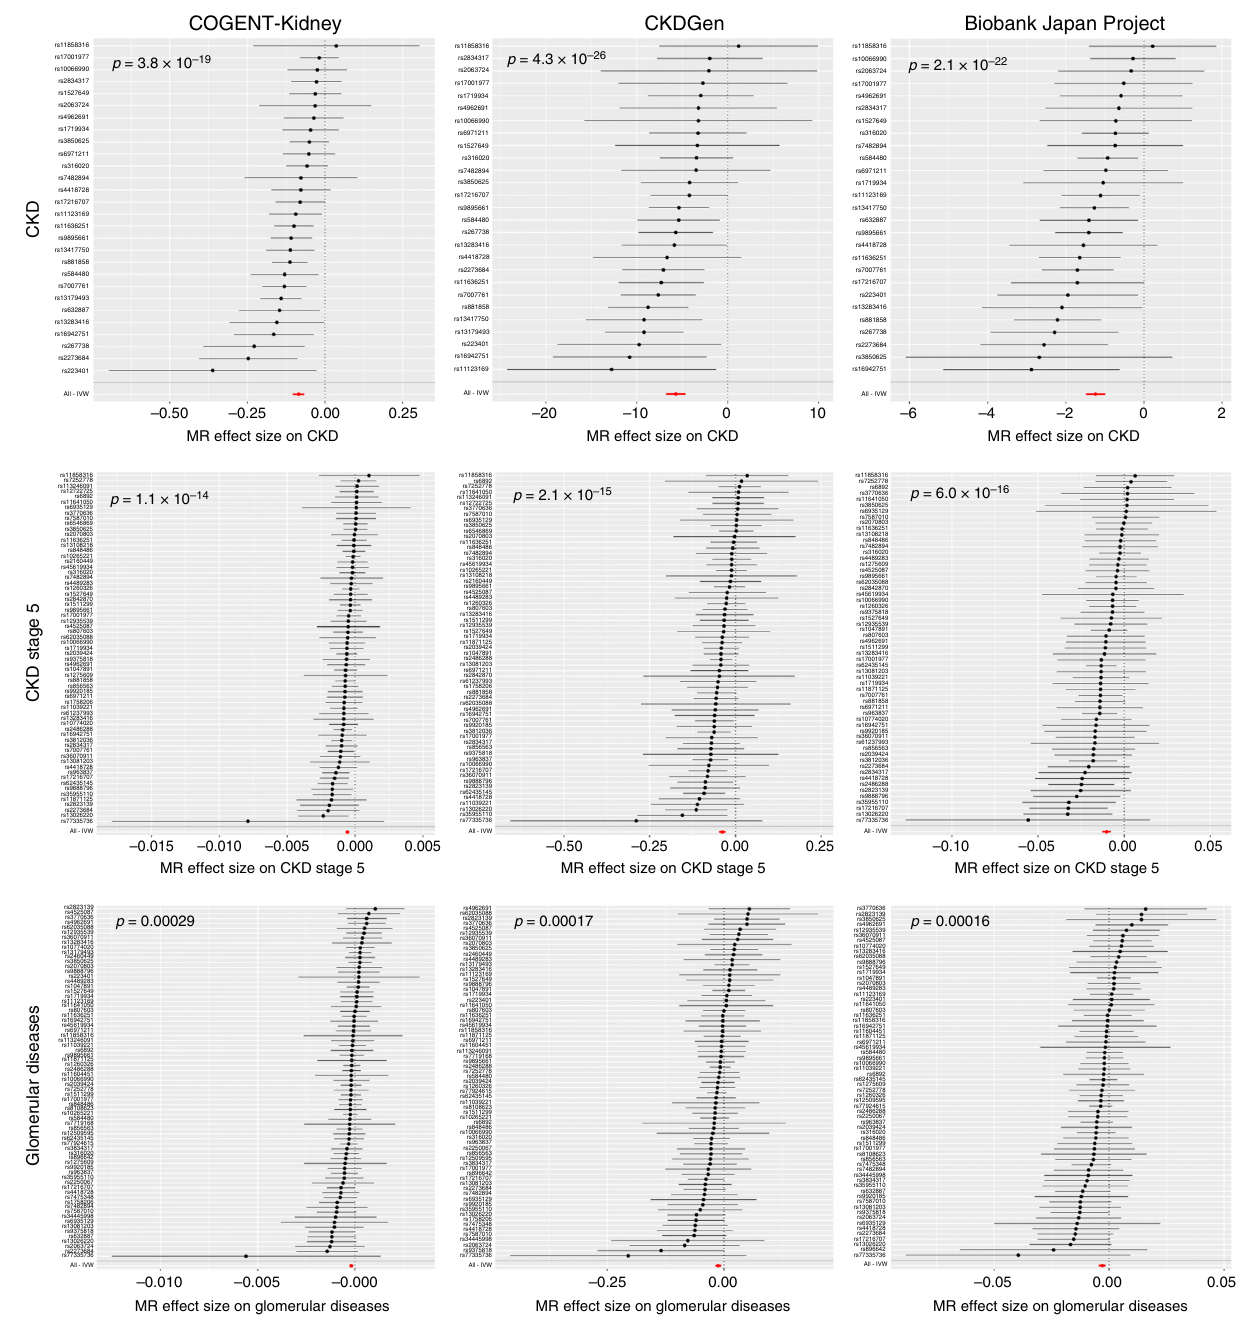
Fig. 2 Two-sample MR of eGFR on CKD and cause-speci fi c kidney disease. Results are presented separately for each component of the trans-ethnic meta- analysis for chronic kidney disease (top), chronic kidney disease stage 5 (middle) and glomerular diseases (bottom). Each point corresponds to a lead SNV (instrumental variable) across 94 kidney function loci, plotted according to the MR effect size of eGFR on the outcome (Wald ratio). Bars correspond to the standard errors of the effect sizes. The red point and bar in each plot represents the MR effect size of eGFR on outcome across all SNVs under inverse variance weighted regression. The p -values are obtained under inverse variance weighted regression. Results for other methods are presented